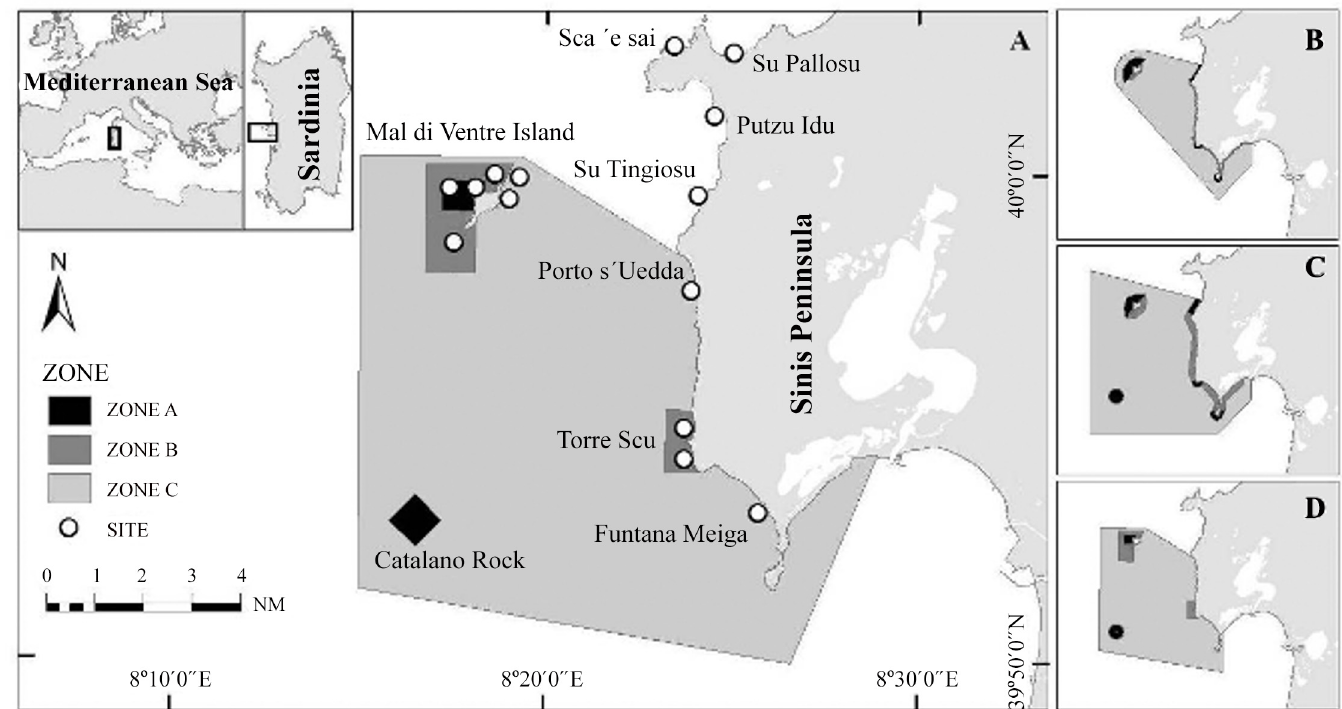
Fig 1. Location and zonation of the “ Penisola del Sinis-Isola di Mal di Ventre ” Marine Protected Area with the sampling sites considered. Zone A: no-take/no-entry area; zone B: general protection area; zone C: partial protection area. The boxes show the changes in zonation in the Sinis MPA since designation: (A) Current zonation, in force since 2011. (B) Zonation proposed before the MPA was established. (C) Zonation adopted when the MPA was established in 1997. (D) Zonation adopted in 2003.